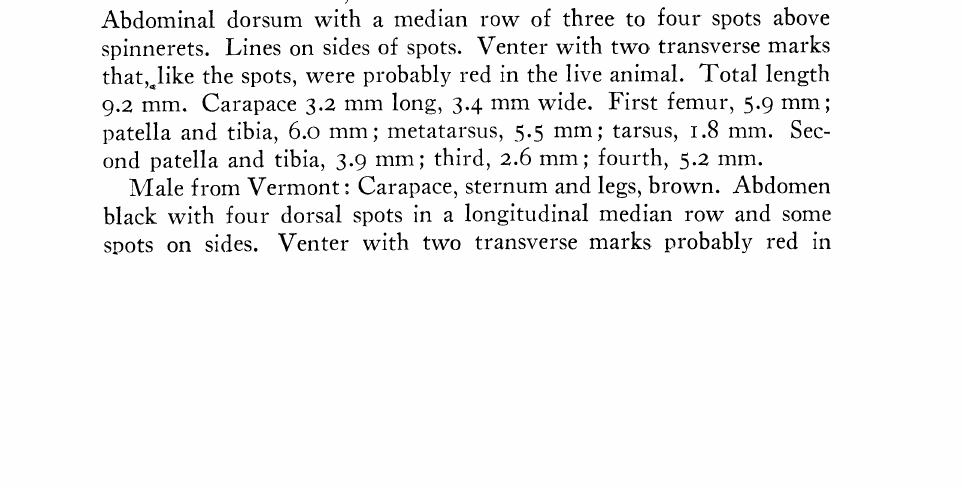
Fig. 9 .Latrodectus formidabilis Walckenaer, I838, p. 647 [--- L. variolus]; Fig. 94 Latrodectus variolus Walckenaer, 838, p. 648; Fig. 95 Latrodectus perfidus Walckenaer, I838, p. 647 [-- L. mactans]; Fig. 39 Latrodectus variol, us Walckenaer, x838, p. 648; Fig. 396 Latrodectus variohts Walckenaer, 838, p. 648. Description o] emale rom Torreya State Park, Liberty County, Florida: Carapace brownish black. Sternum, legs., abdomen, black. Dorsum oten with a median longitudinal row o red spots. Venter with two transverse red bars (Fig. 27). Total length ram. Cara- pace 4.2 mm long, 3.8 mm wide. First femur, 8.o mm; patella and tibia, 9.8 ram; metatarsus, 8.3 ram; tarsus, 2.5 ram. Second patella and tibia, 5.o ram; third, 4.2 ram; ]ourth, 7.3 ram. Male from Torreya State. Park: Carapace brown. Sternum dark brown. Legs: coxae dark brown; proximal portion o first femora, brown; patellae brown; other parts, orange, except brown at distal ends o tibiae. Abdomen black, dorsum variable with two to three red spots in a median longitudinal line; sometimes orange lines going down sides rom spots, and a line above spinnerets. Venter with two red transverse bars. Total length 6.7 ram. Carapace 2.7 mm long, 2. mm wide. First emur, 6.5 ram; patella and tibia, 7.6 ram; metatarsus, 7.3 ram; tarsus, 2. ram. Second patella and tibia, 4.2 ram; third, 2.7 ram; ourth, 5.9 ram. Female from Dover, Massachusetts: Color as in Florida emale.